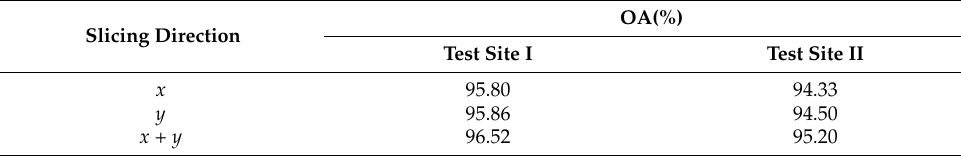
Table 7. Influence of slicing